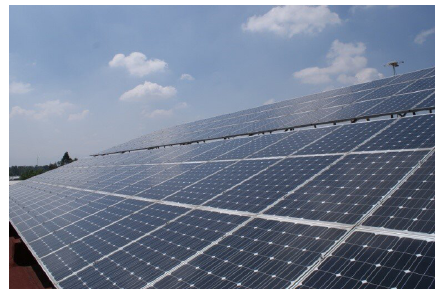
Figure 6. Physical system for the Mexico City site (MCS).